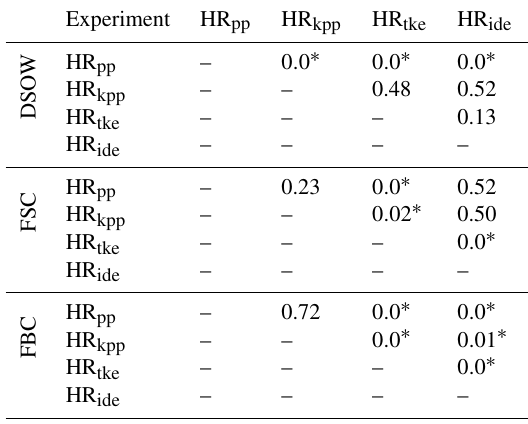
Table A1. Resulting p values from Welch’s two-sided t tests ( α = 0 . 05 and n = 20) for testing the differences in mean overflow vol- umes of DSOW, in the FSC, and in the FBC.